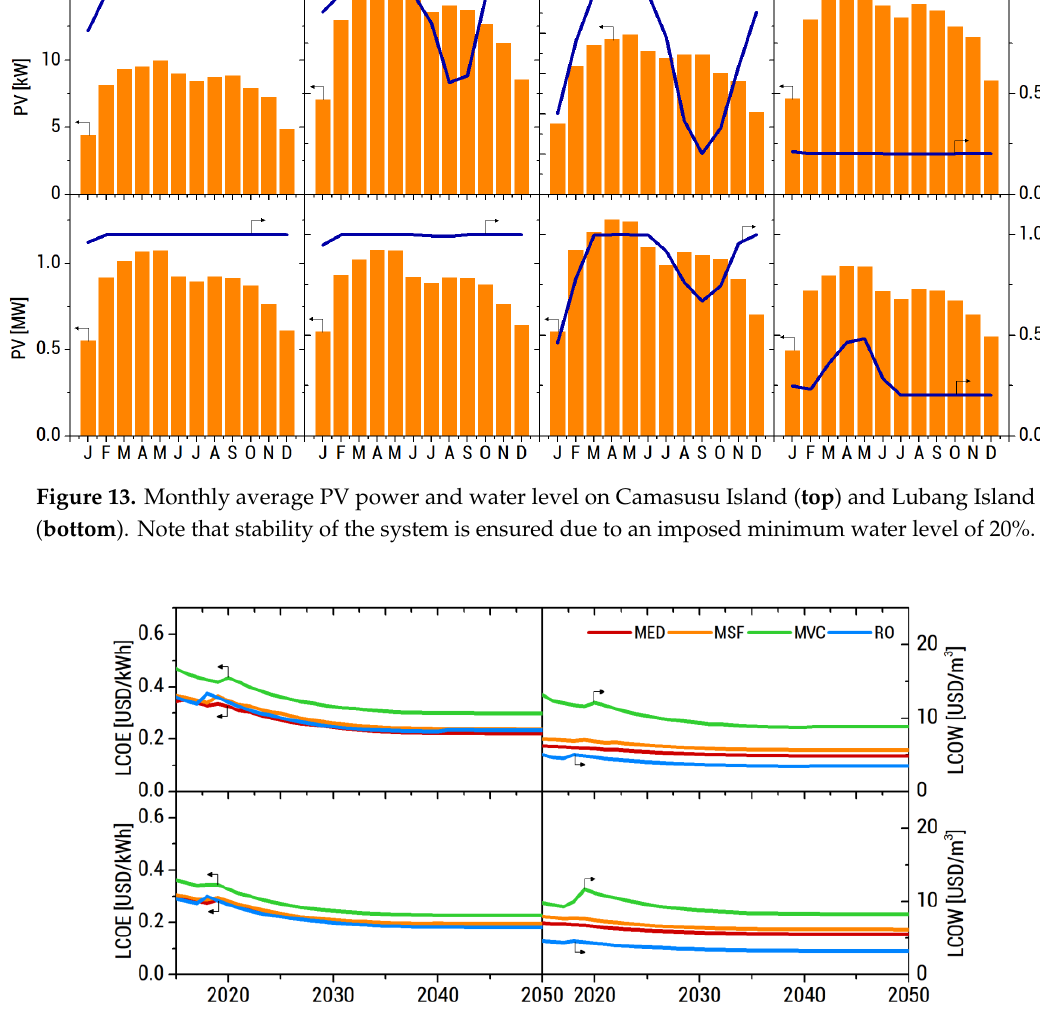
Figure 14. Projected LCOE and LCOW on Camasusu Island ( top ) and Lubang Island ( bottom ). The bumps near 2020 indicates a shift to a more RE-favored optimum configuration.